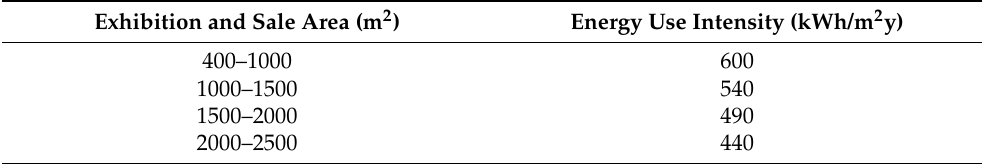
Table 2. A possible classification of food retail structures based on sale area and energy